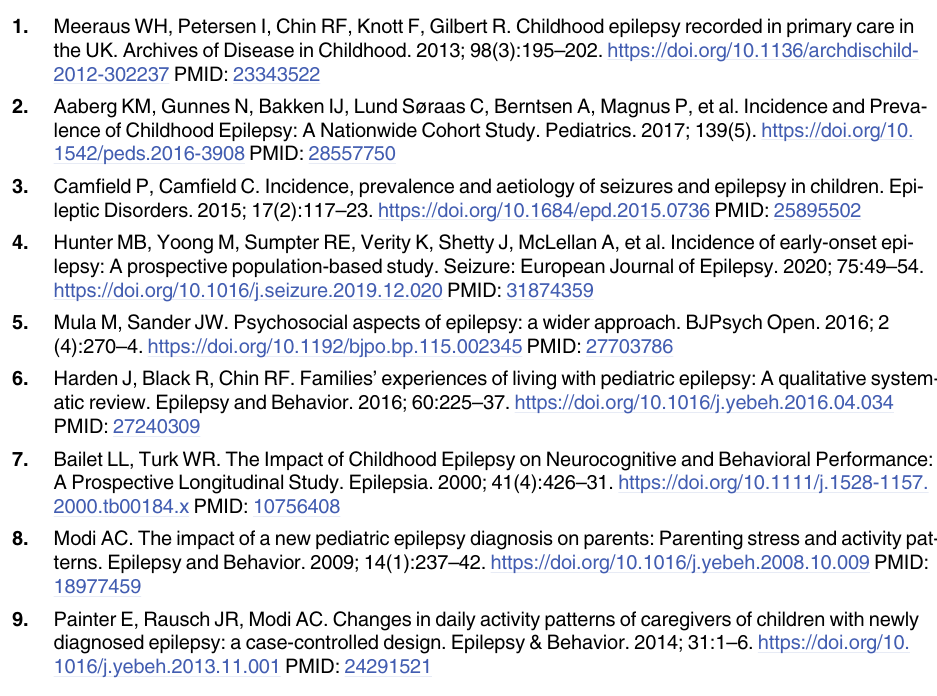
S6 Table. Mixed Methods Appraisal Tool (MMAT).